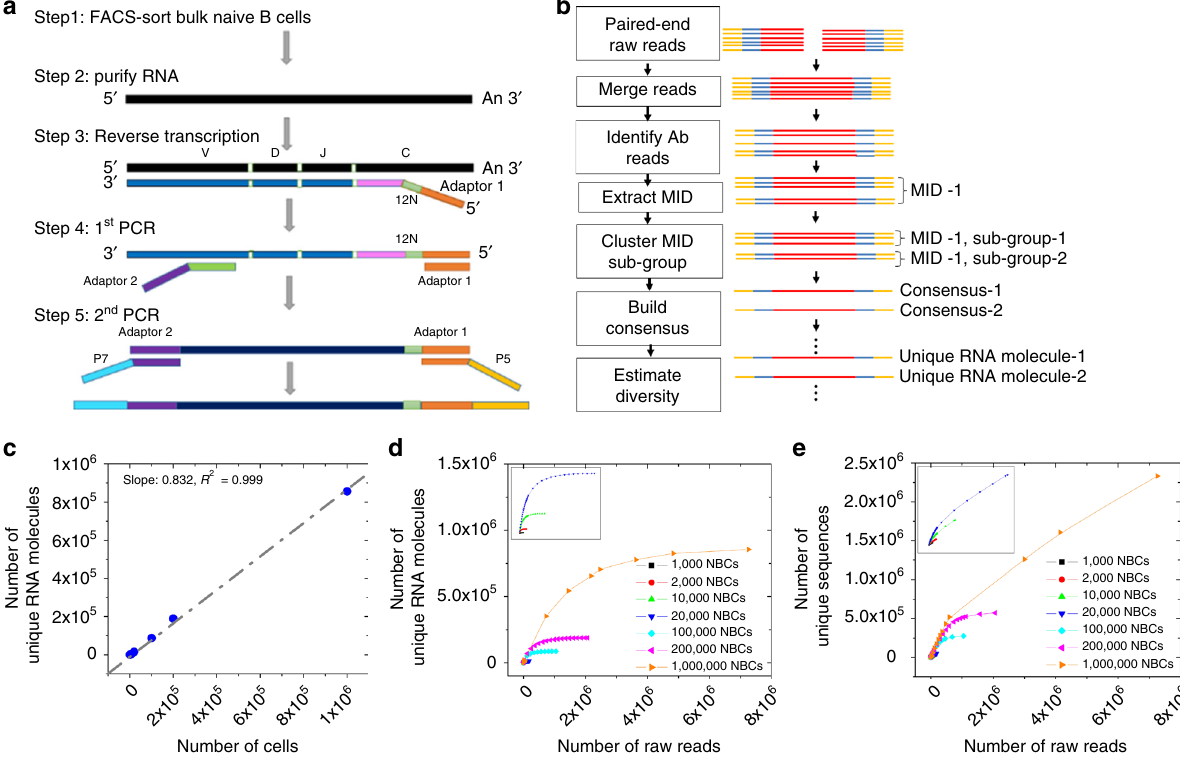
Fig. 1 Ultra-accurate high coverage of antibody repertoire with a large dynamic range of input cells for MIDCIRS. a Schematic overview of tagging single immunoglobulin transcripts with MIDs. b Schematic overview of the informatics pipeline of MIDCIRS which includes merging paired-end reads, performing clustering to generate MID sub-groups, and building consensus sequences. c Correlation between number of cells and number of unique RNA molecules after using MIDCIRS. RNA from as few as 1000 to as many as 1,000,000 naive B cells was used as input material in generating the amplicon libraries. Slope indicates the estimated diversity coverage. d , e Rarefaction analysis of optimum sequencing depth for each sample with ( d ) and without ( e ) using MIDCIRS. NBCs naive B